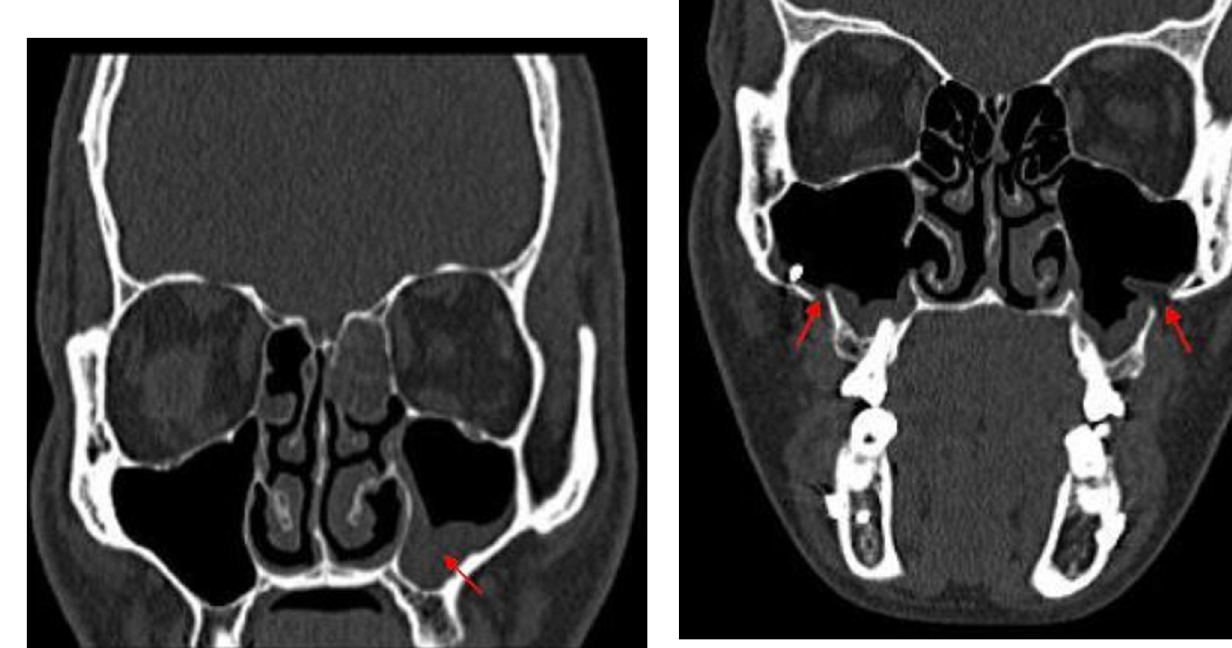
Fig. 8. Postoperative coronal CT image showing persistent bony dehiscence at the base of the maxillary sinus (arrows) with evidence of mucosal thickening in the bilateral maxillary